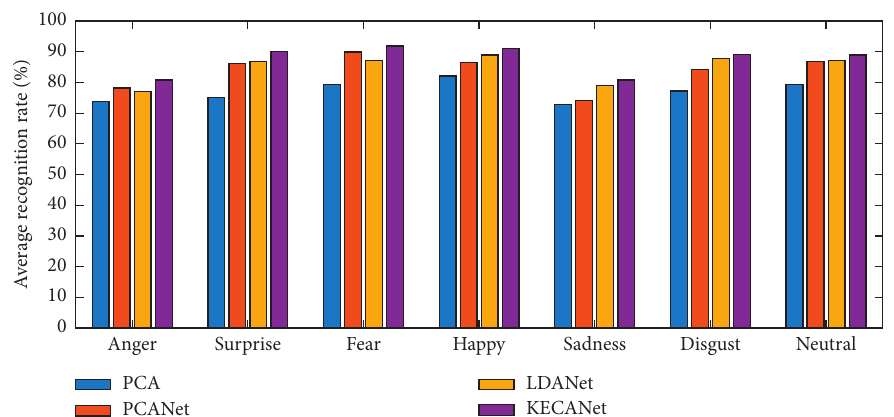
Figure 13: Comparing the test accuracies on the JAFFE dataset.